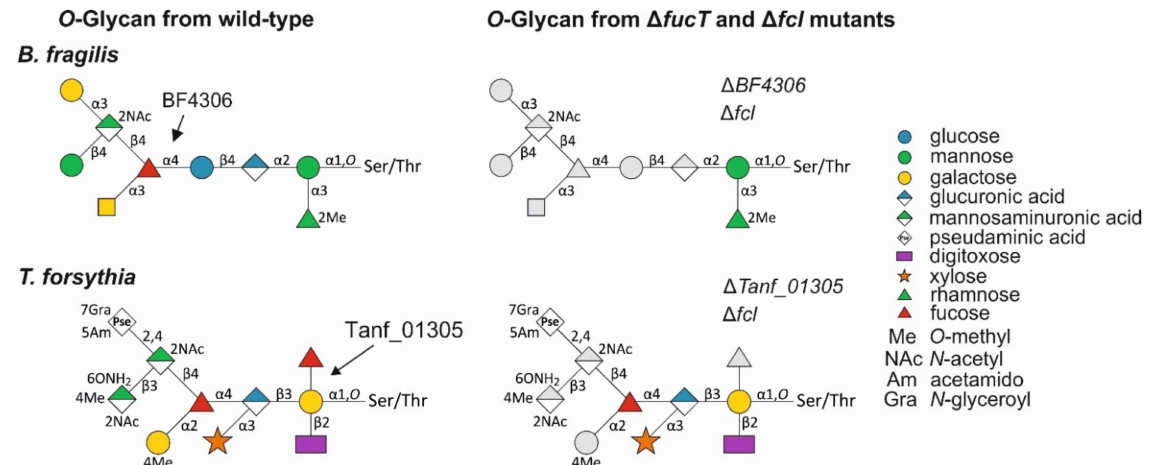
Figure 8. Comparison of the O -linked glycan structures from B. fragilis wild-type (this study), B. fragilis ∆ BF4306 (this study) , B. fragilis ∆ gmd-fcl ∆ fkp [16], T. forsythia wild-type [10], T. forsythia ∆ Tanf_01305 [10], and T. forsythia ∆ fcl (this study). The severe truncation of the glycans upon deletion of the fucT or the fcl gene is indicated in grey. Glycan structures are drawn according to the symbol nomenclature of glycans SNFG